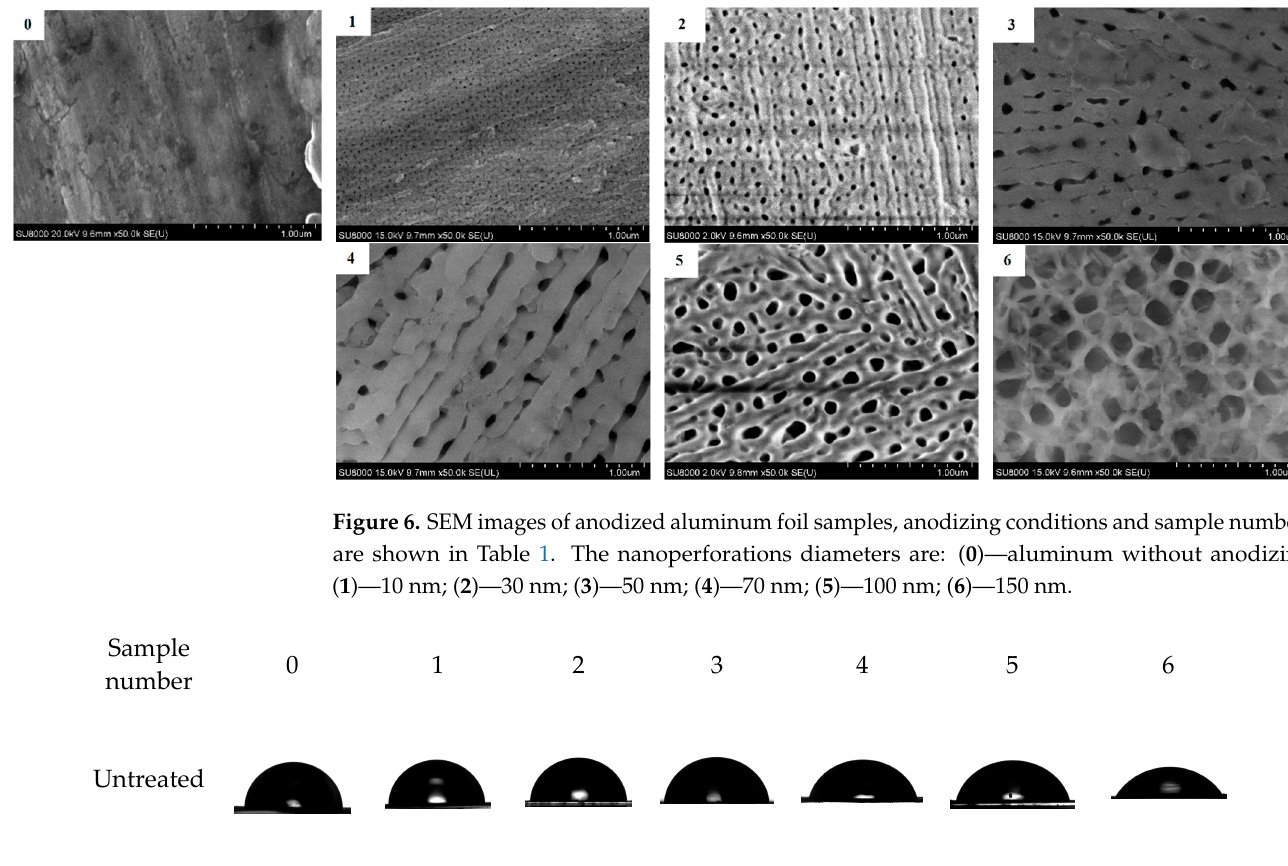
Figure 7. Water contact angles comparison of pictures of modified and untreated anodized aluminum foil samples.